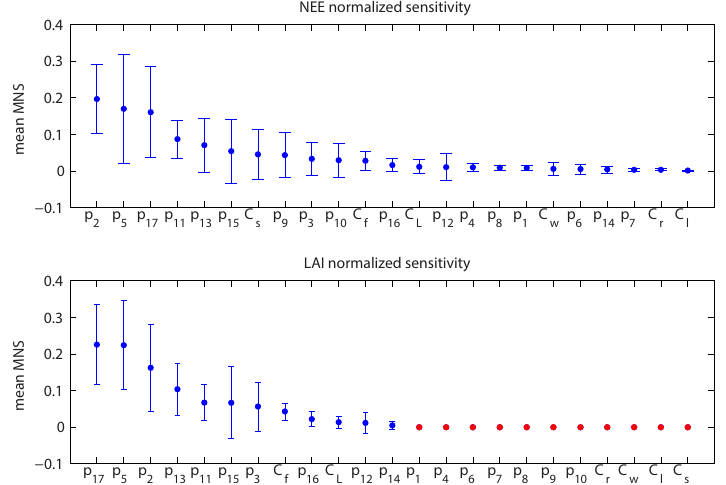
Figure 2. Mean normalised sensitivities (MNS): 100 parameter sets satisfying EDCs are sampled at the Morgan Monroe State Forest. Parameters are ranked in decreasing order according to their sensitivity, the blue dots represent the mean of the MNS (dimensionless quantity), the intervals represent 1 σ error bars and the red dots correspond to null